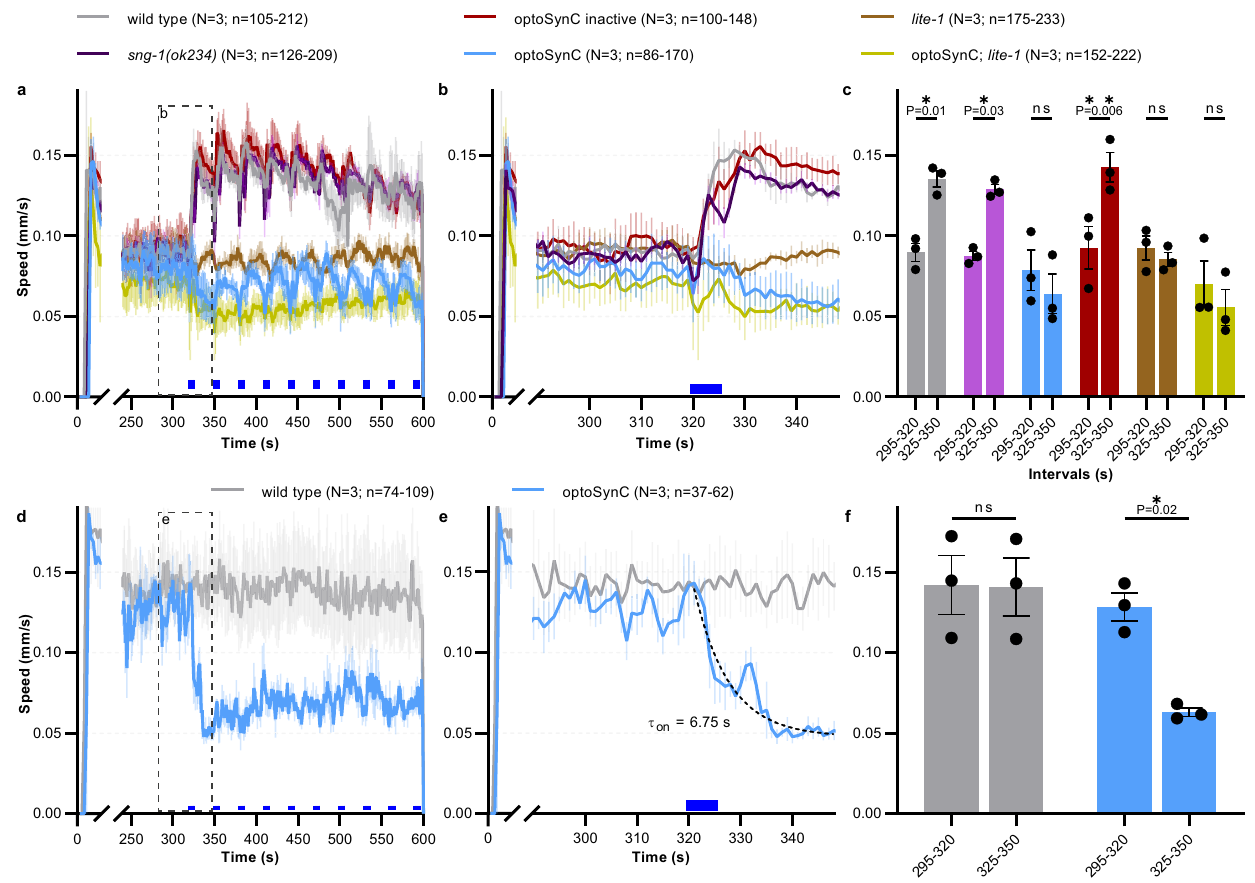
Fig. 2 | Immediate inhibition of the LITE-1-dependent escape response by optoSynC. a Mean±s.e.m crawling speed analysis, blue light application (470nm, 1mW/mm², 5s / 25s ISI, indicated by blue rectangles), genotypes as indicated (optoSynC expressing animals are in sng-1(ok234) background). b Close-up of box indicated in a . c Group data, mean crawling speed of animals tested in N =3 inde- pendent experiments (±s.e.m), analyzed as mean of time intervals before